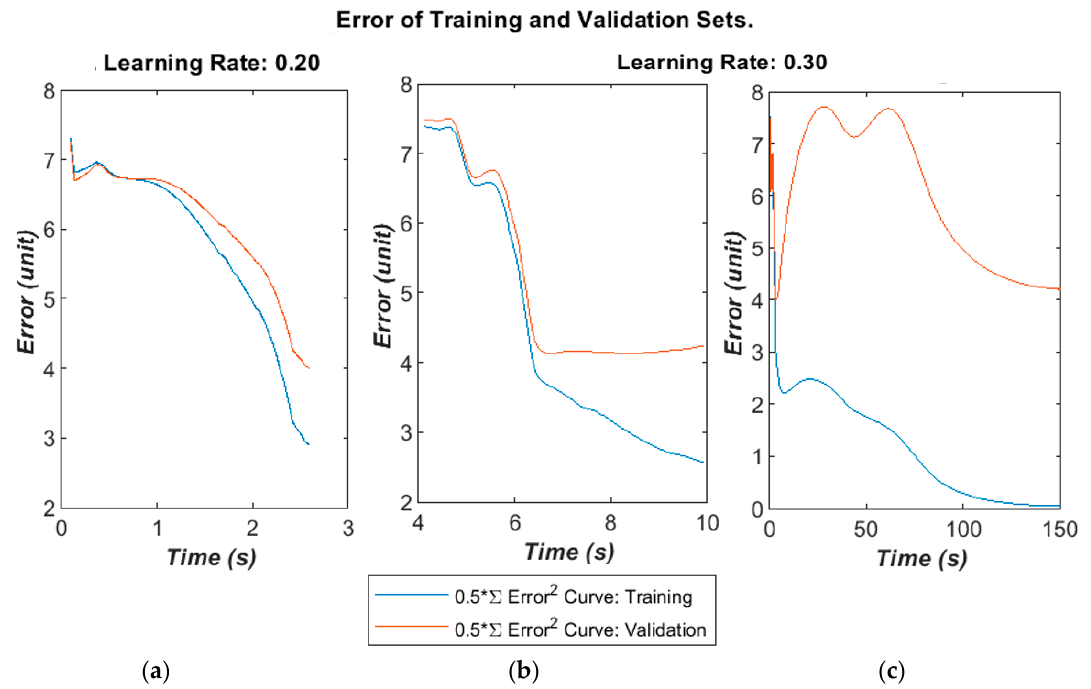
Figure 7. ( a ) Training and validation dataset error falling together. ( b ) Errors begin to diverge. ( c ) Training error starts to overfit, while validation error converges to an error energy of 4.